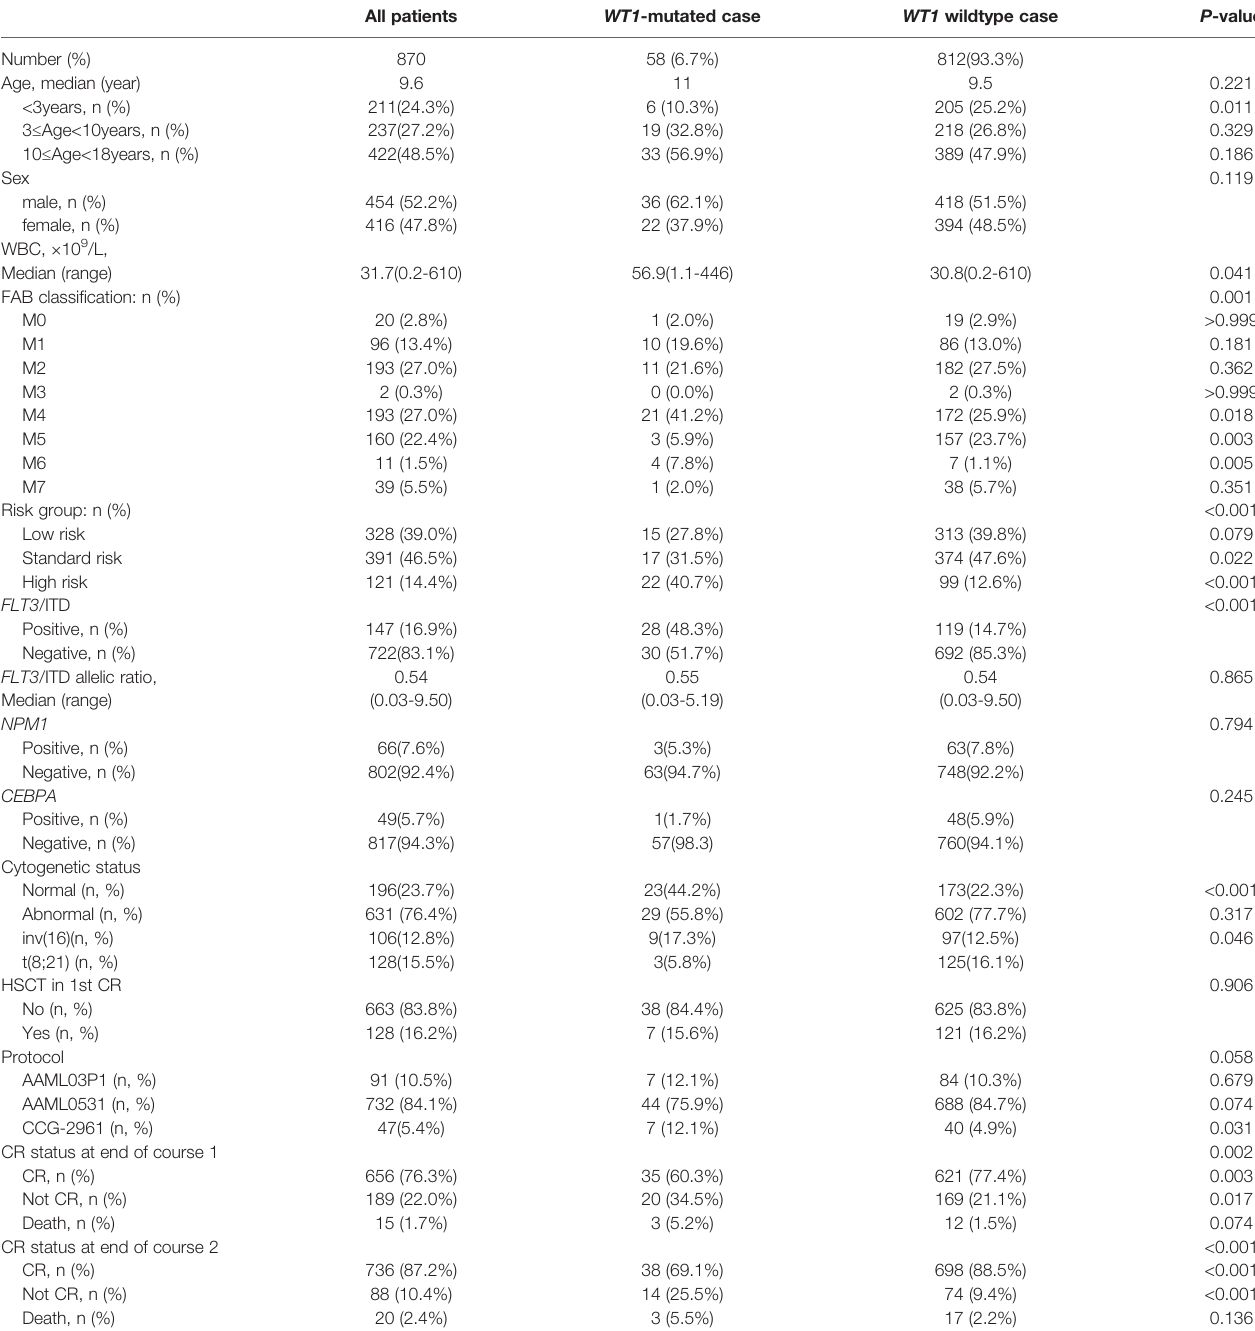
TABLE 1 | Characteristics of pediatric patients with or without WT1 mutations. All patients WT1 -mutated